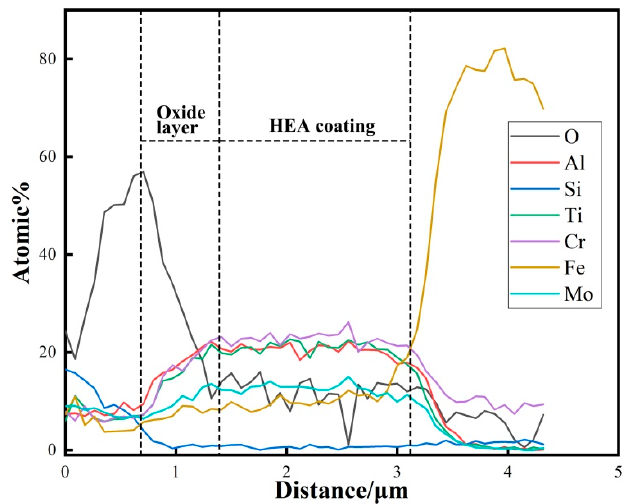
HEA coating at 550 °C for 500 h; ( f ) EDS analysis of the microzone shown in ( c , d ).